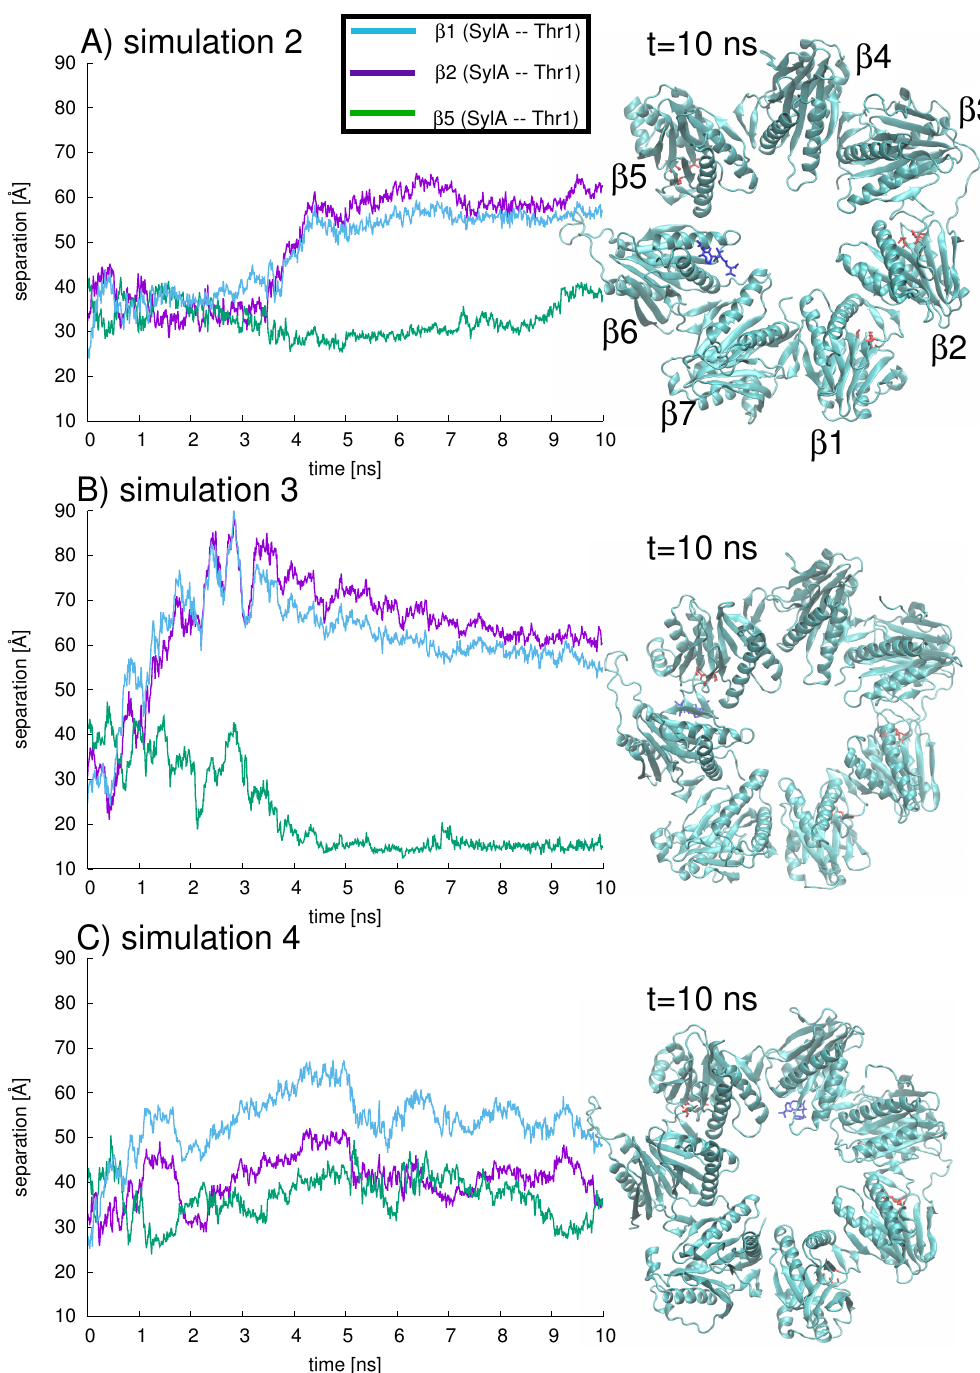
Figure 7. Three independent simulations, labeled simulation 2, 3, and 4 (shown in figures A–C, respectively), were carried out with the B 1 +SylA complex over 10 ns. In each simulation, the SylA position with respect to the three binding sites is quantified by the separation of SylA C 4 from the Thr1-O γ of β 1 (blue), β 2 (purple), and β 5 (green). Snapshots of the SylA inhibitor (dark blue) inside the B 1 ring (active sites depicted in red) are shown for each simulation at t = 10